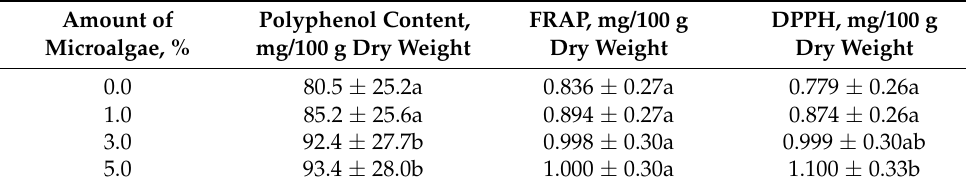
Table 9. Polyphenol content and antioxidant activity of bread with microalgae. Amount of Microalgae, %